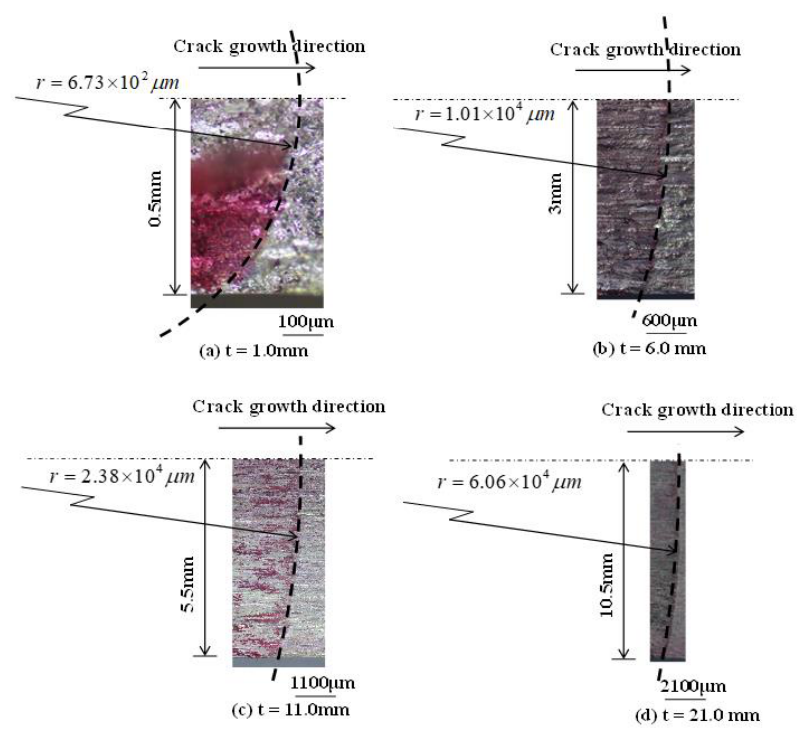
Figure 9. Leading edge shapes of the cracks of specimens with various thicknesses. ∆ K = 12.0 MPam 1/2 , ( a ) t = 1 mm; ( b ) t = 6 mm; ( c ) t = 11 mm; ( d ) t = 21 mm.